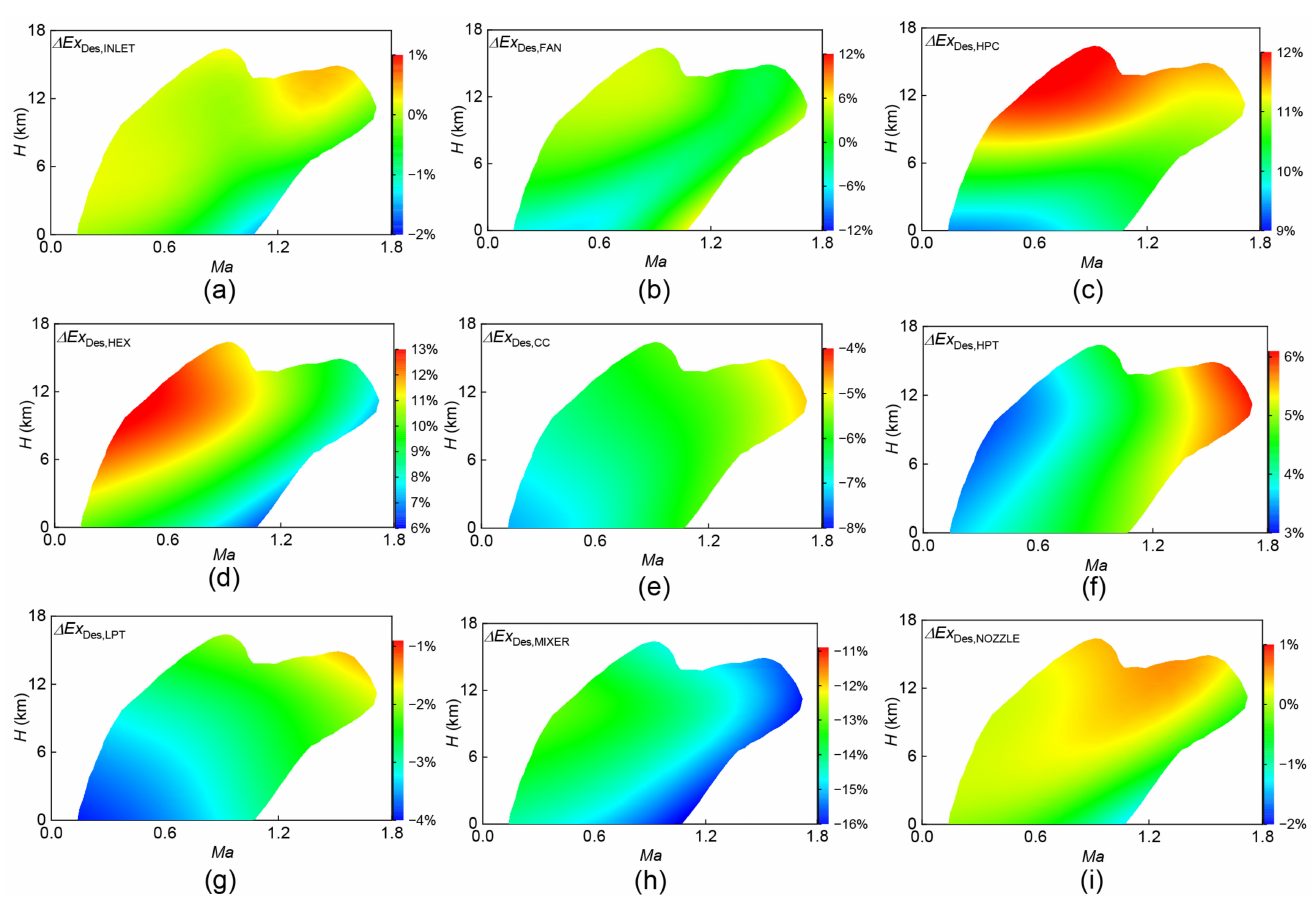
Figure 18. Variations of local exergy destruction in the full flight envelope. ( a ) INLET; ( b ) FAN; ( c ) HPC; ( d ) HEX; ( e ) CC; ( f ) HPT; ( g ) LPT; ( h ) MIXER; ( i )